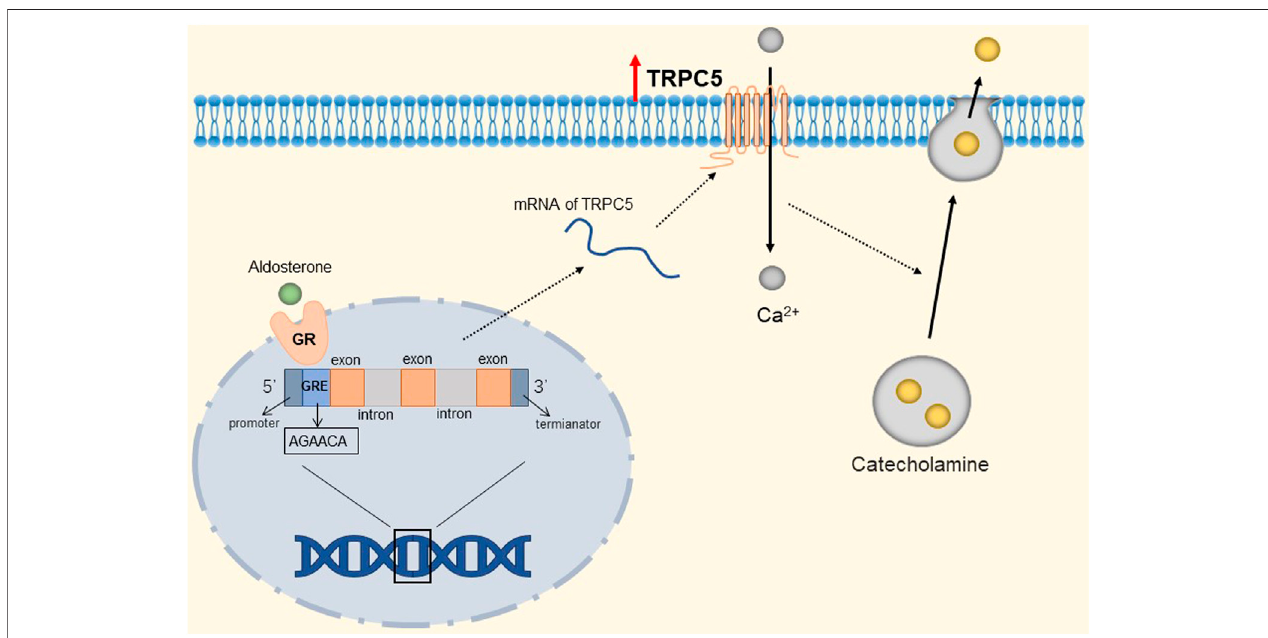
FIGURE 5 | Mineralocorticoid-mediated up-regulation of TRPC5. The GRE-like half-site (AGAACA) in the TRPC5 gene binds to the mineralocorticoid receptor, prompting theup-regulation ofTRPC5 channels. TRPC5 isactivated tomediatethe in fl uxofCa 2+ intochromaf fi n cells,depolarizingchromaf fi ncells andpromptingtheir secretion of